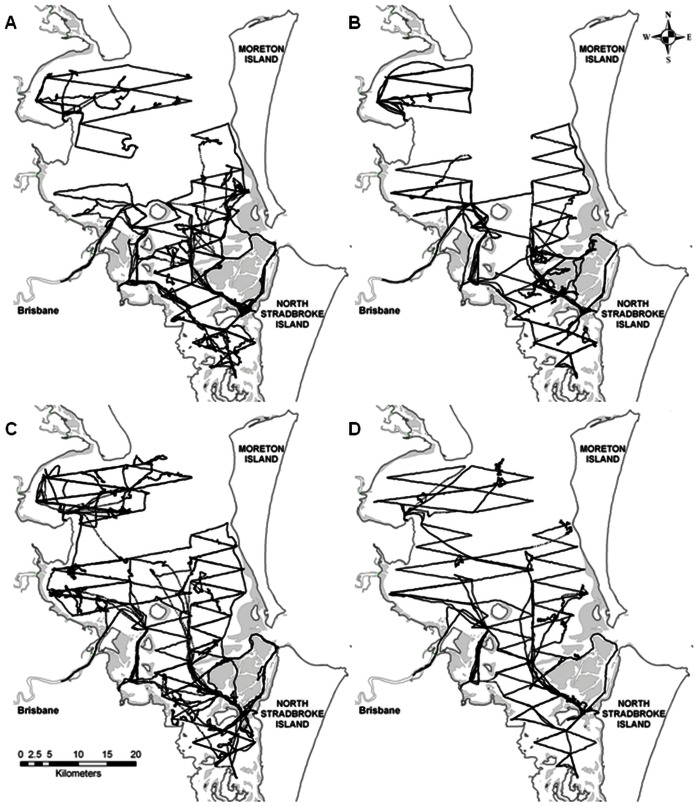
Survey effort across four field seasons in Moreton Bay.GPS track records of boat survey effort in Moreton Bay during four field seasons: A) July–September 2008, B) January–March 2009, C) July–September 2009, D) January–March 2010.